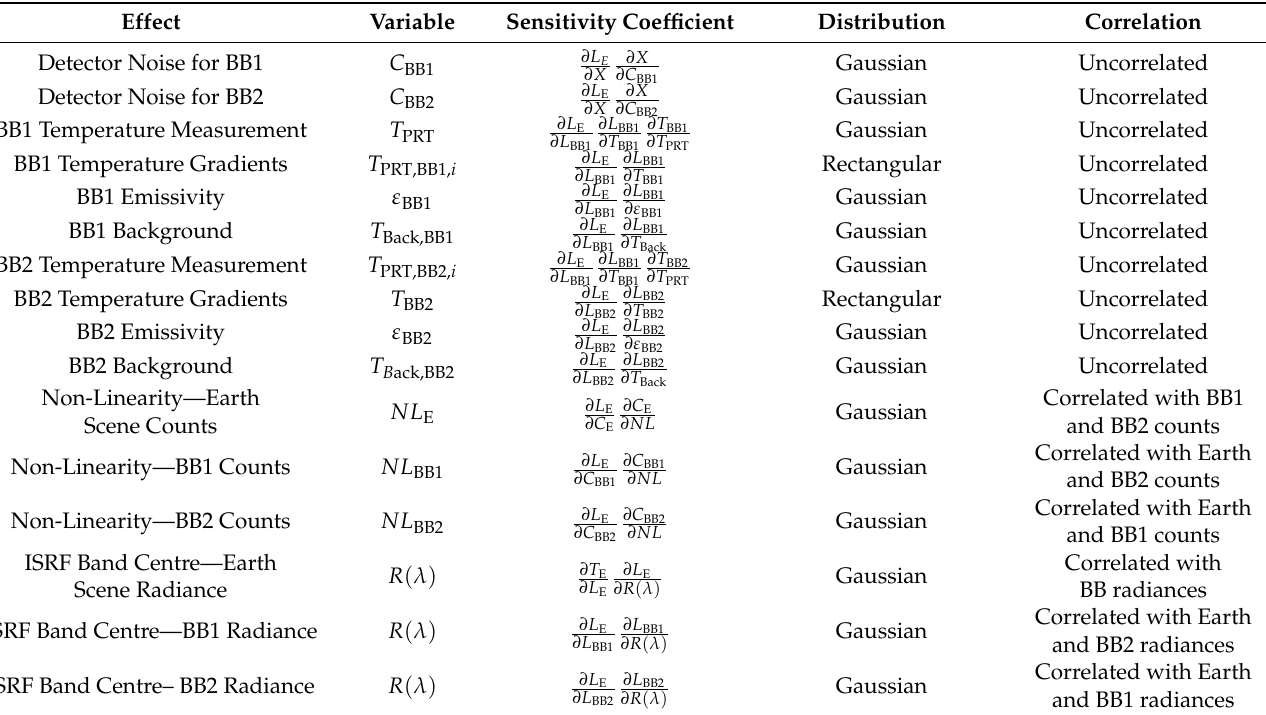
Table 9. Correlations of terms used in deriving individual per-pixel uncertainties in the SLSTR Level-1 BTs. Effect Variable Sensitivity Coefficient Distribution